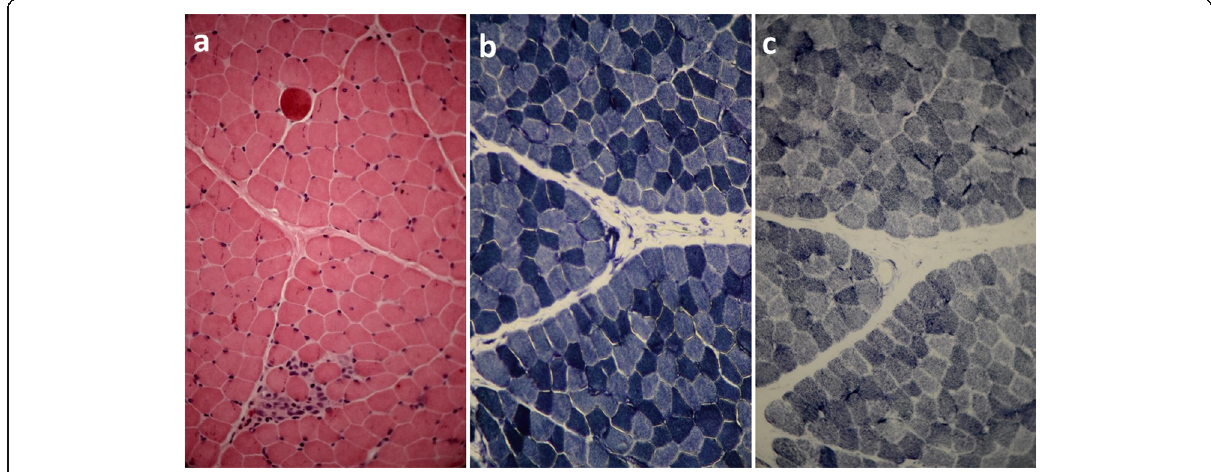
Fig. 2 Muscle biopsy studies of the patient V1 when sataining with H & E ( a ), NADH-TR ( b ), SDH ( c ). All figures are (× 400)